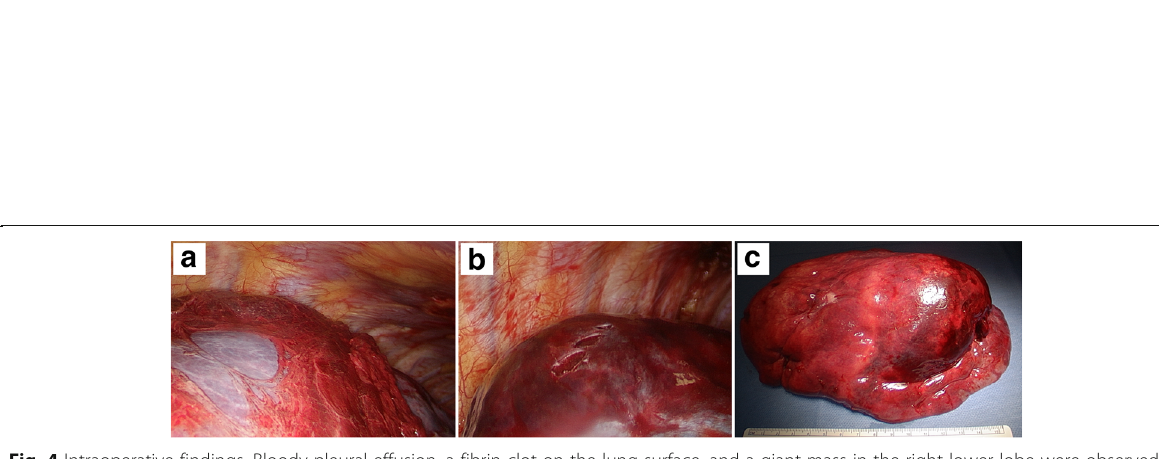
Fig. 4 Intraoperative findings. Bloody pleural effusion, a fibrin clot on the lung surface, and a giant mass in the right lower lobe were observed. There was evidence of injury to the visceral pleura ( a , b ). Resected right lower lobe. The gross size of the tumor was 9.0 × 8.0 cm ( c )